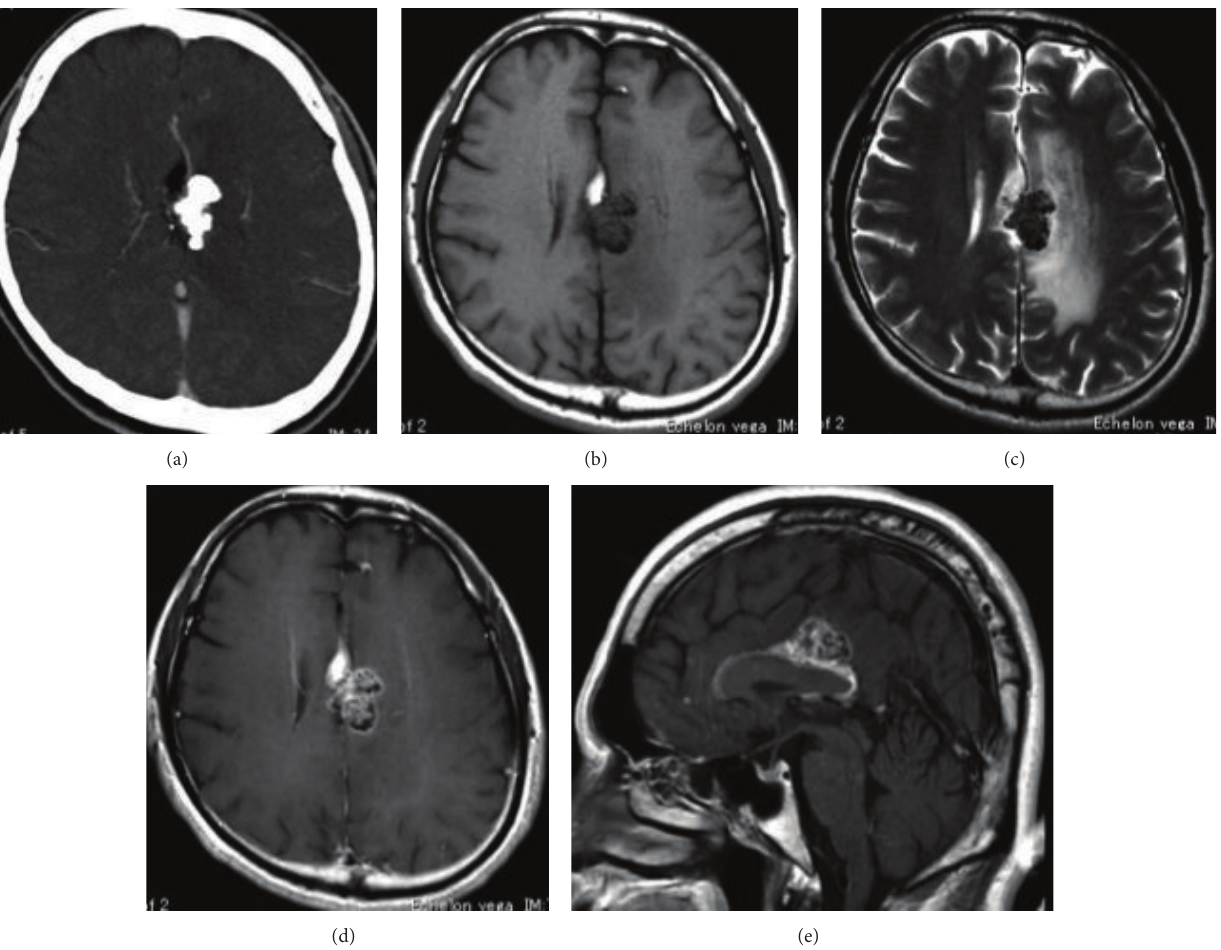
Figure 1: (a) Preoperative computed tomography (CT) showing calcified tumor in the interhemispheric fissure. (b, c) Preoperative magnetic resonance imaging (MRI) showing a lesion along the corpus callosum, appearing hyperintense on T1-weighted imaging (b) and isointense on T2-weighted imaging (c) associated with expanding perifocal edema. (d, e) The mass shows heterogeneous enhancement with gadolinium or axial (d) and sagittal images (e).